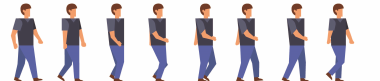
Figure 4. Gait cycle. Free image download from www.vecteezy.com (accessed on 4 November